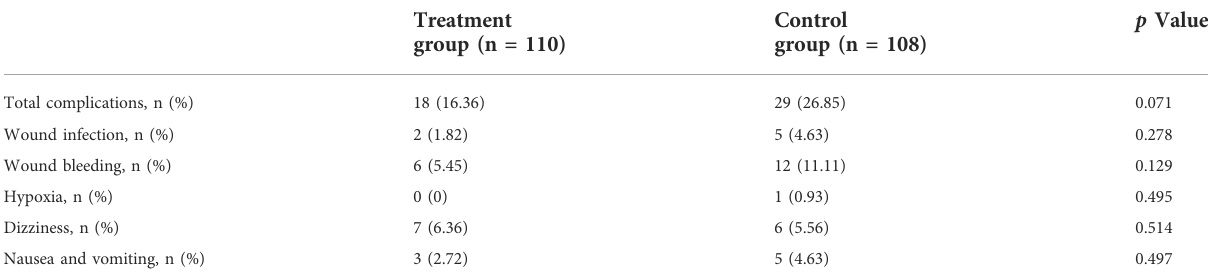
TABLE 3 The comparison of complications between the 2